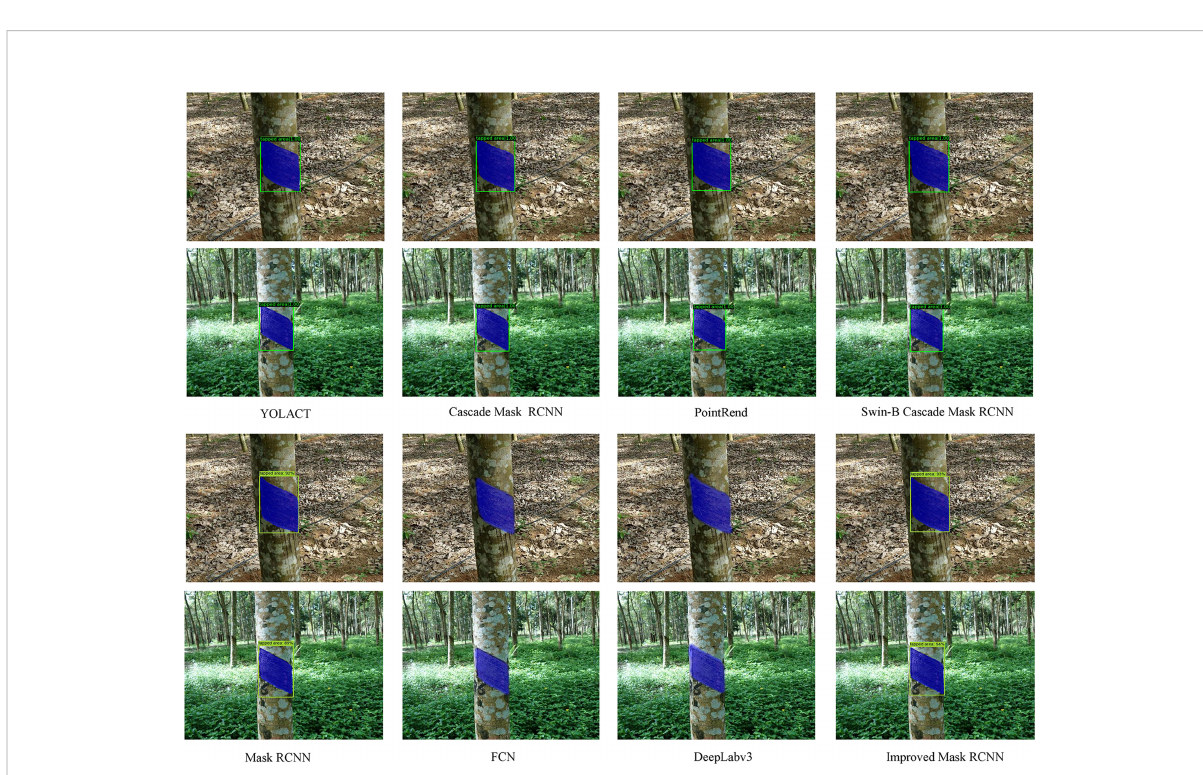
FIGURE 8 Tapped area detection and segmentation results of natural rubber trees of different